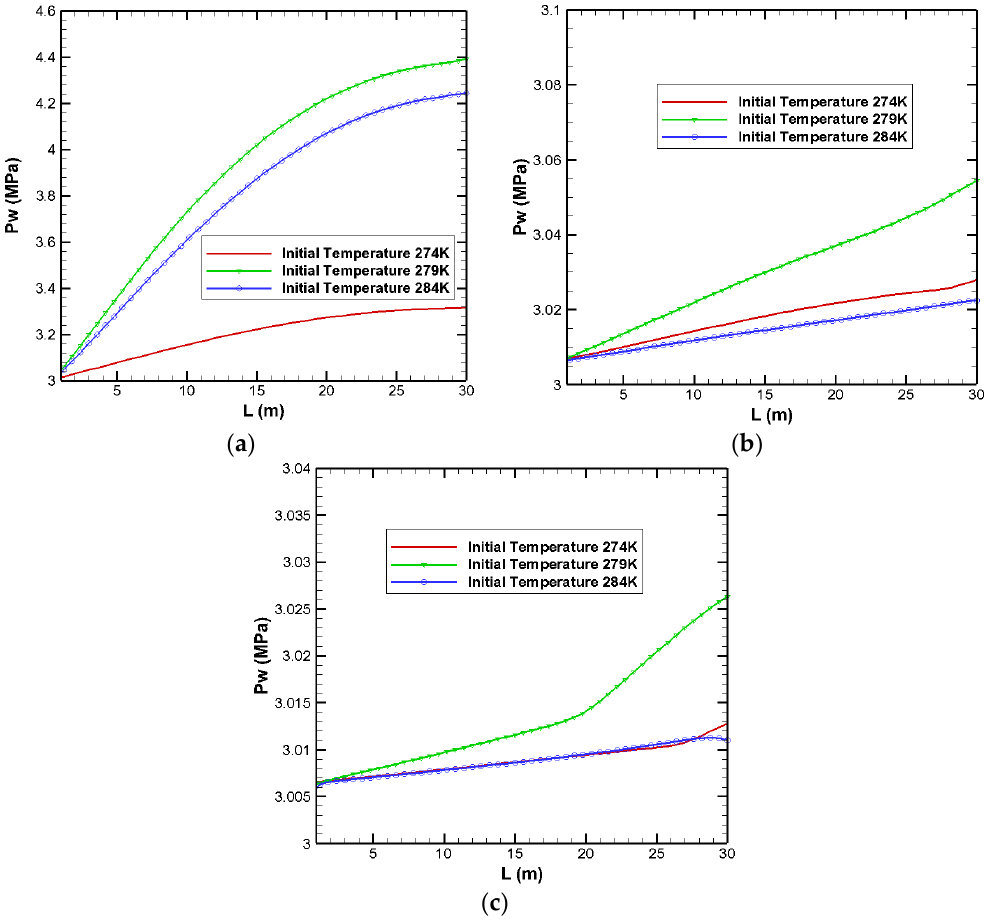
Figure 3. Comparisons of pressure distributions in reservoir under different initial temperatures (274 K, 279 K, and 284 K) at different exploiting time ( a ) 300 min; ( b ) 3000 min; ( c ) 30,000 min.